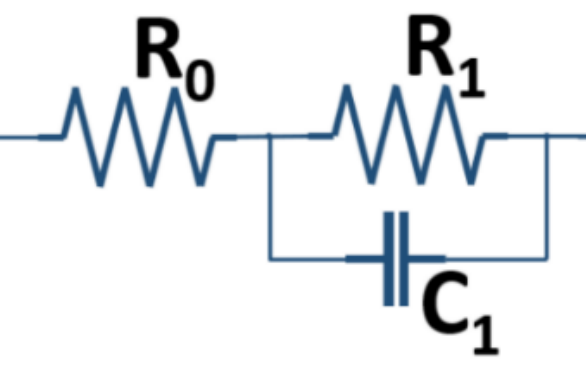
(1) Figure 3. R-C parallel (Kelvin–Voigt type) model. The equivalent impedance, Z K-V ( s ), contains a product RC ≡ τ, which is the time constant, and R ≡ H, is the system gain when s → 0 and the root of the denominator (pole) is (cid:4672)− (cid:2869) (cid:3099) (cid:4673) :